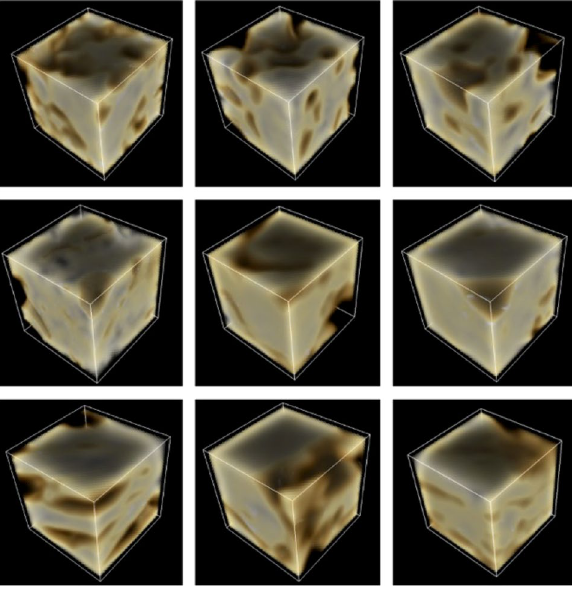
Fig. 11 Examples of class 4 subblocks